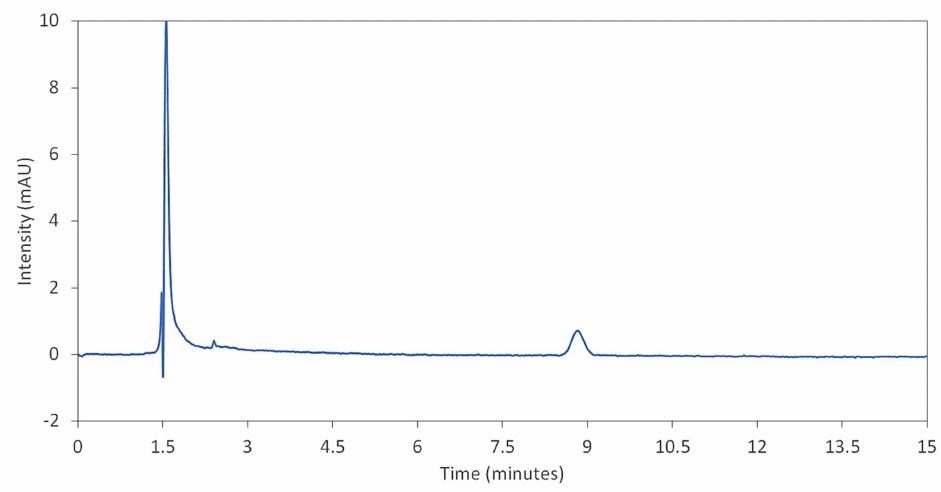
Figure 4. Chromatogram of a solution containing Cr(VI) (60 µ g dm − 3 and Cr(III) (280 mg dm − 3 ). Although Cr(III) and protein interferences can be mitigated with the chromatographic method, dyes can still be a significant interference. Figure 5 is a chromatogram overlay (normalised arbitrary intensity) comparing a model Cr(VI) solution (blue), the extract from a Cr(VI)-free leather containing yellow dye (green) and the extract from a Cr(VI)-free leather containing red dye. Both dyed leathers showed significant dye leaching, which was present after a solid phase extraction step with a C18 silica medium (ACROS Chemicals, Cumbria, UK). The colourants used were examples of acid (anionic) dyes, which are impeded by the cationic exchange medium. Comparing peak 1 (Cr(VI), no dye) with peak 2 (no Cr(VI), yellow dye) shows how persistent dyes can be removed as an interference as the retention times are clearly different. However, comparing peak 1 and peak 3 (no Cr(VI), red dye) demonstrates there are situations, whereby a dye that can absorb at 372 nm and have a retention time matching Cr(VI), thus giving a false positive result.